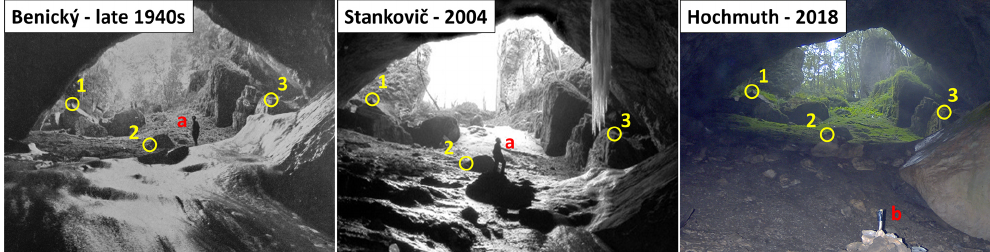
Figure 2. Photographic evidence of cave floor ice in the Silická l’adnica cave over the last 80 years. All three photos are captured from approximately the same position (shown in Fig. 3 as a red point A) from inside the cave outward and show different states of cave floor ice. Identical points are marked in yellow. As a scale, objects marked in red can be used – (a) is the figure of a speleologist and (b) is a wooden stick 30cm high. Based on the photographs we can conclude that there is a gradual loss of ice. The photographs were taken in different years but also at different periods within the